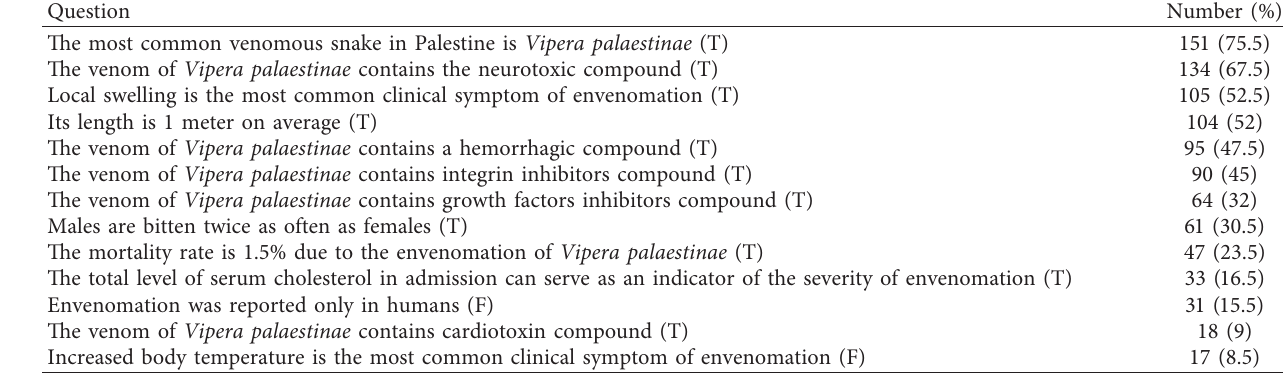
Table 3: Percentages of correct responses of nursing students to questions on knowledge regarding Vipera palaestinae . Question